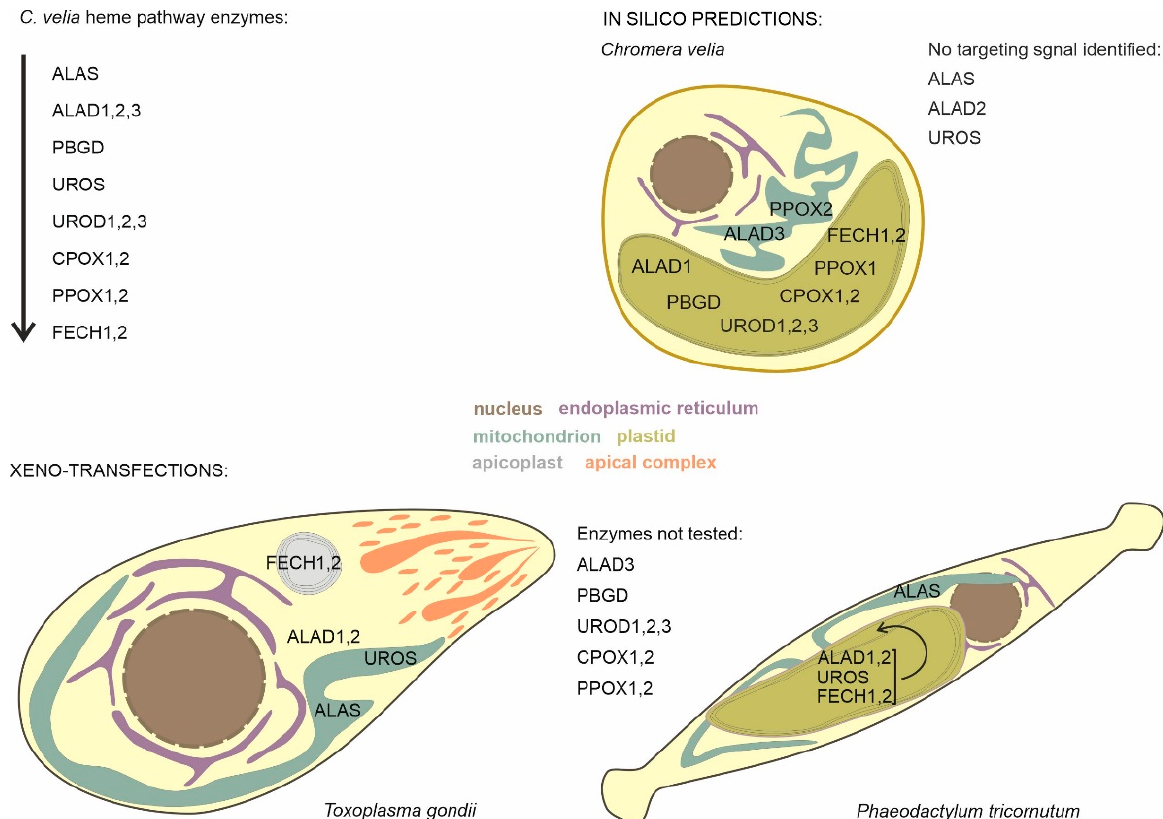
Figure 8. Intracellular distribution of heme biosynthesis in Chromera velia , inferred from predictions, and heterologous reporter gene expression in Toxoplasma gondii and Phaeodactylum tricornutum .